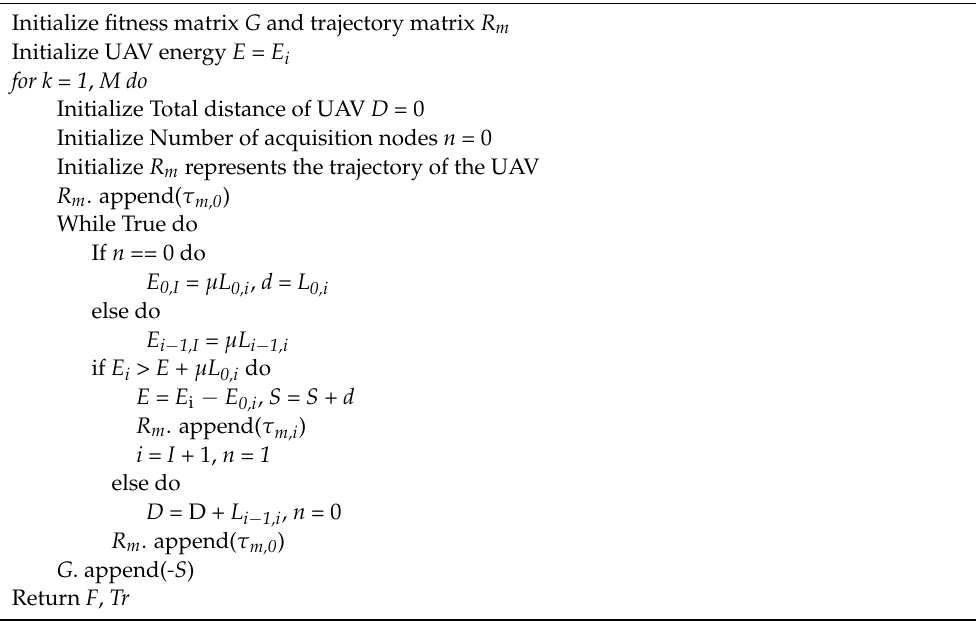
Algorithm 1: UAV flight trajectory and fitness